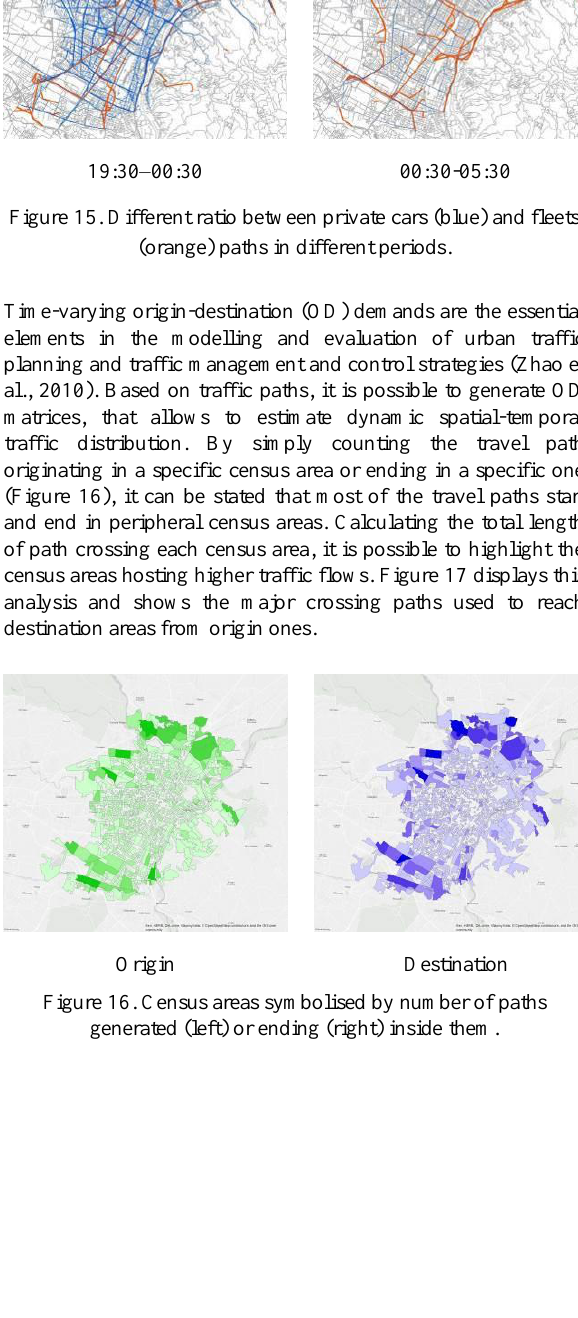
Figure 13. Mean speed recorded over the whole road network (green = lower speed, red = higher speed).